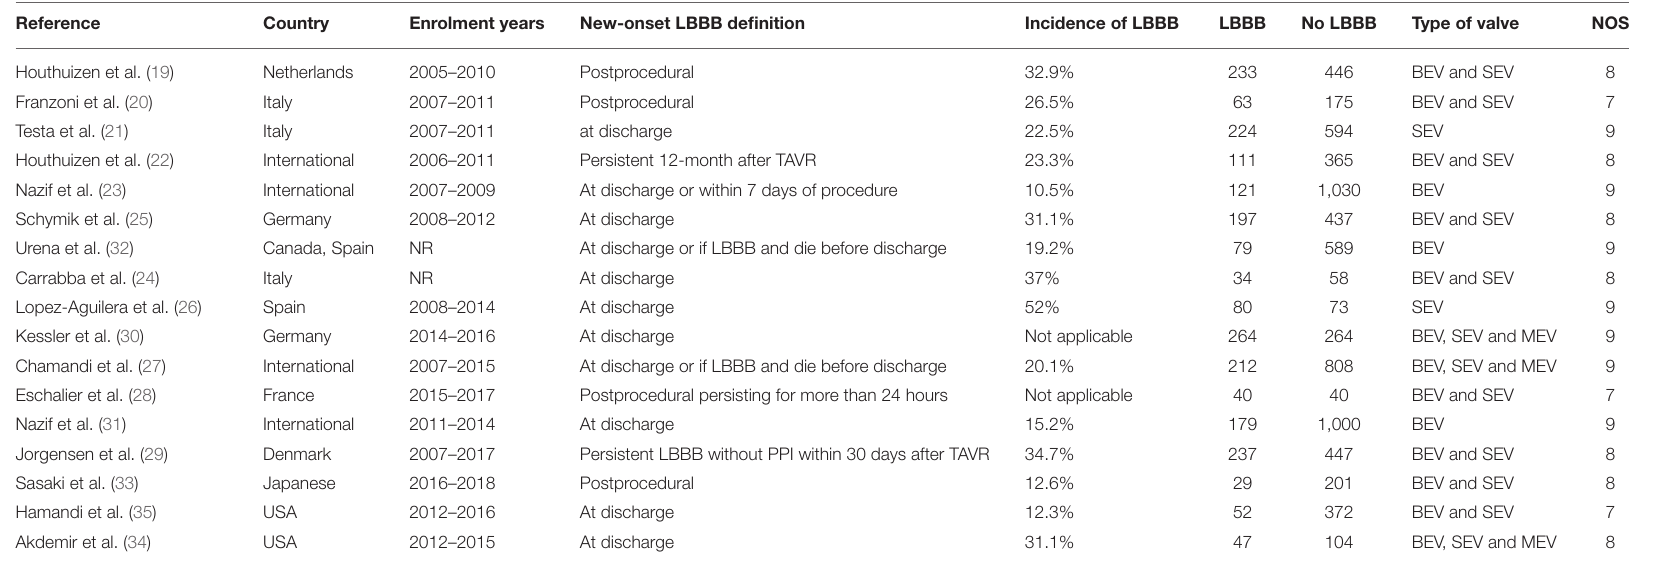
TABLE 1 | Characteristics of included